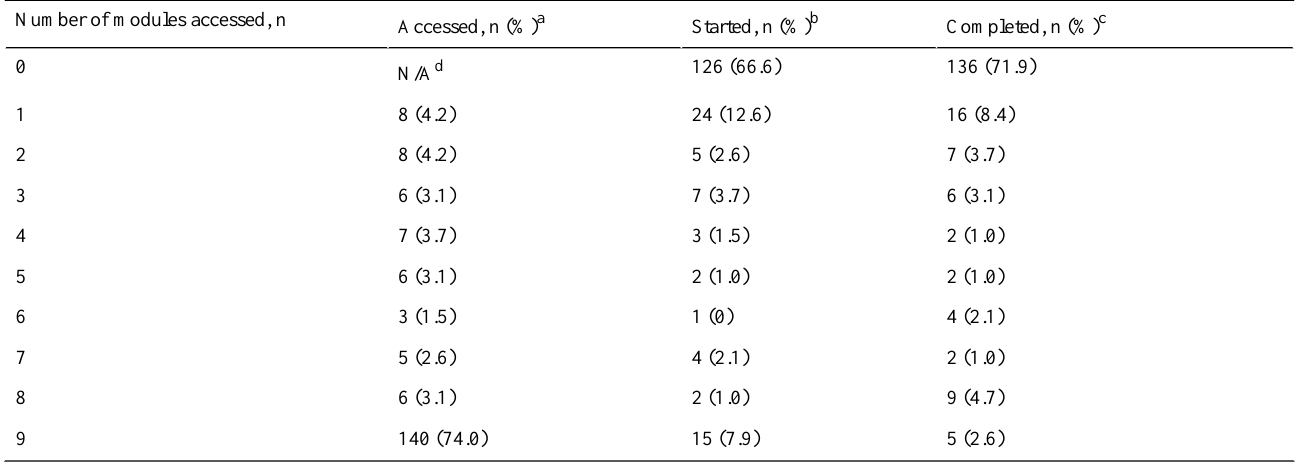
Table 2. Number of Diabetes Engagement and Activation Platform modules accessed, started, and completed by intervention patients